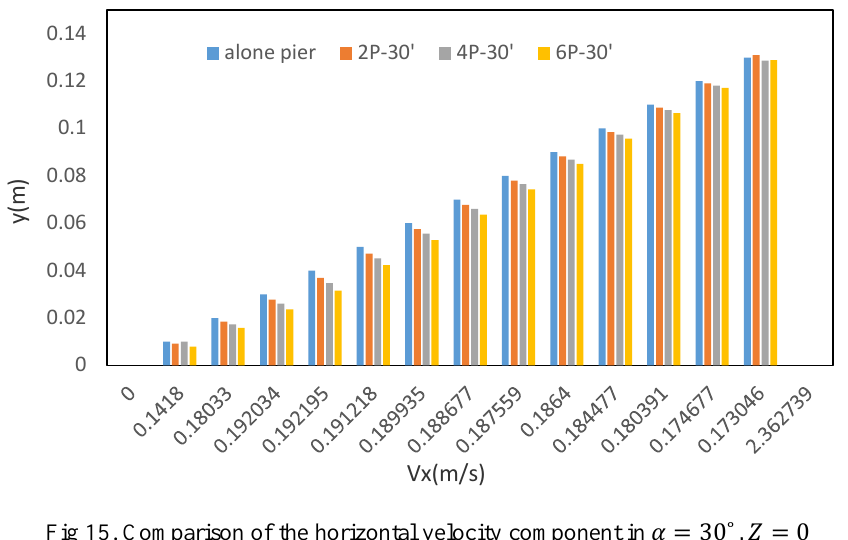
Fig 15. Comparison of the horizontal velocity component in 𝛼 = 30˚ , 𝑍 = 0